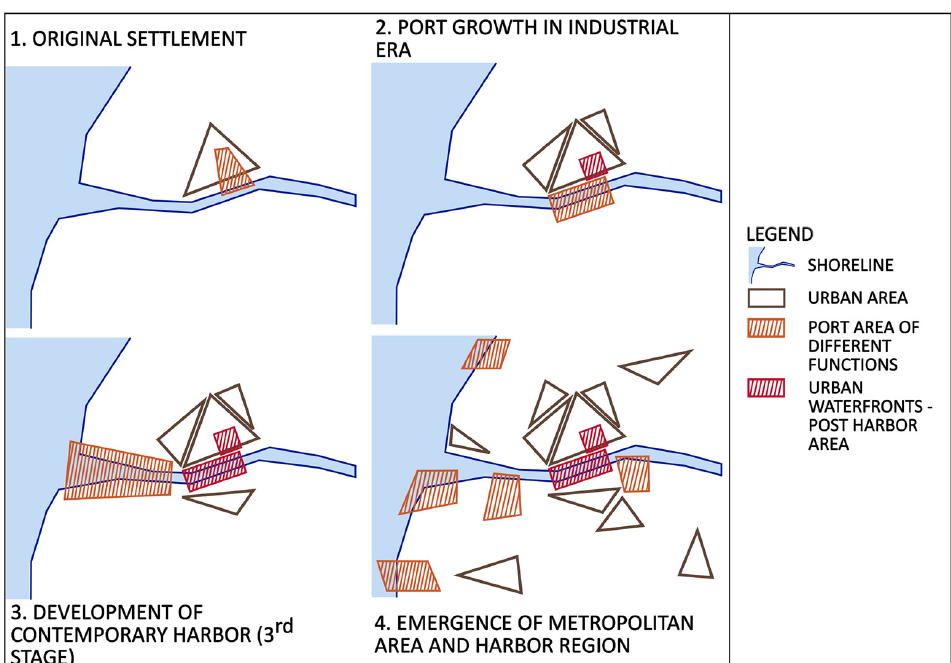
Figure 1. Rotterdam: The evolution of the port‐city area. Source: Based on Meyer (1991), reinterpreted by the